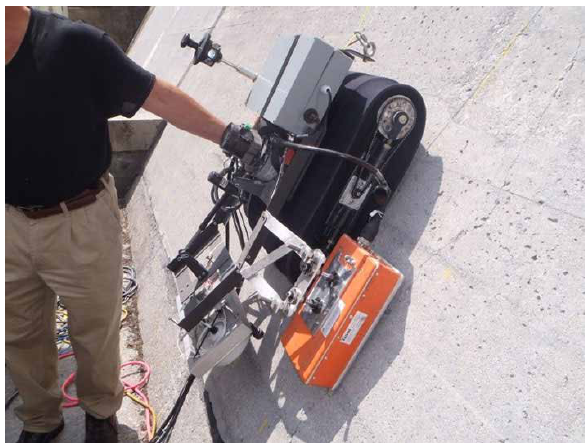
Figure 9. Smith Mountain Hydroelectric facility and